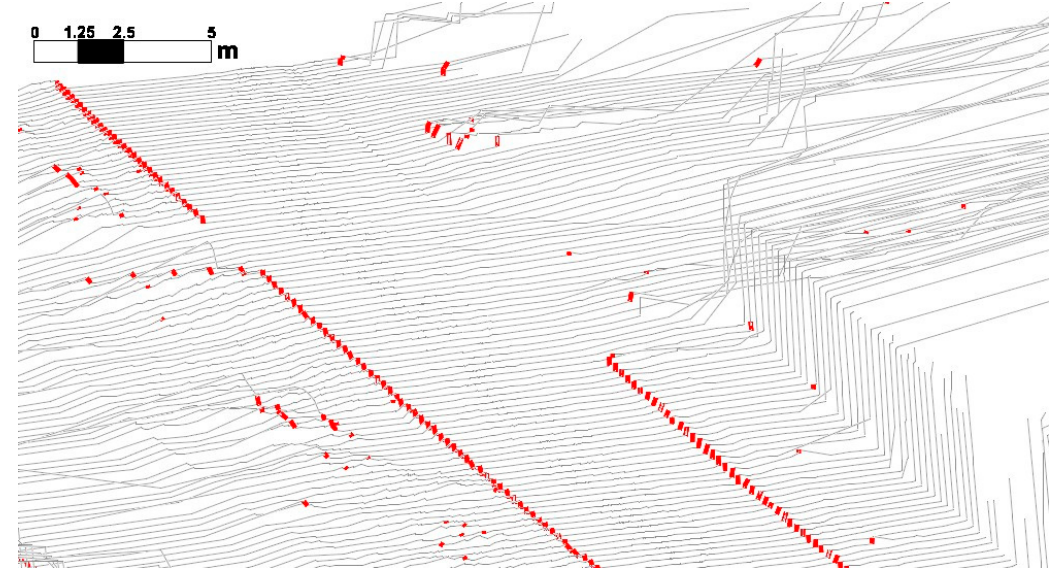
Figure 12. Monotone chains clean result, after intervals restriction for the height and slope.